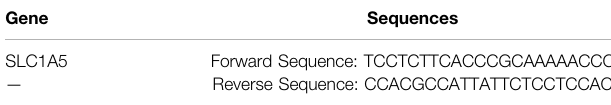
TABLE 1 | Primer sequences for quantitative